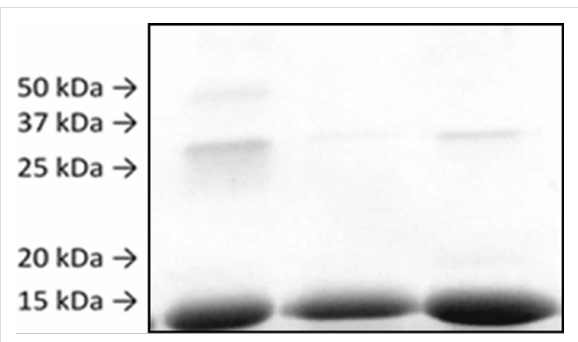
Figure 6: SDS-PAGE separation of lysozyme after modification with 11 (left), 13 (middle), 15